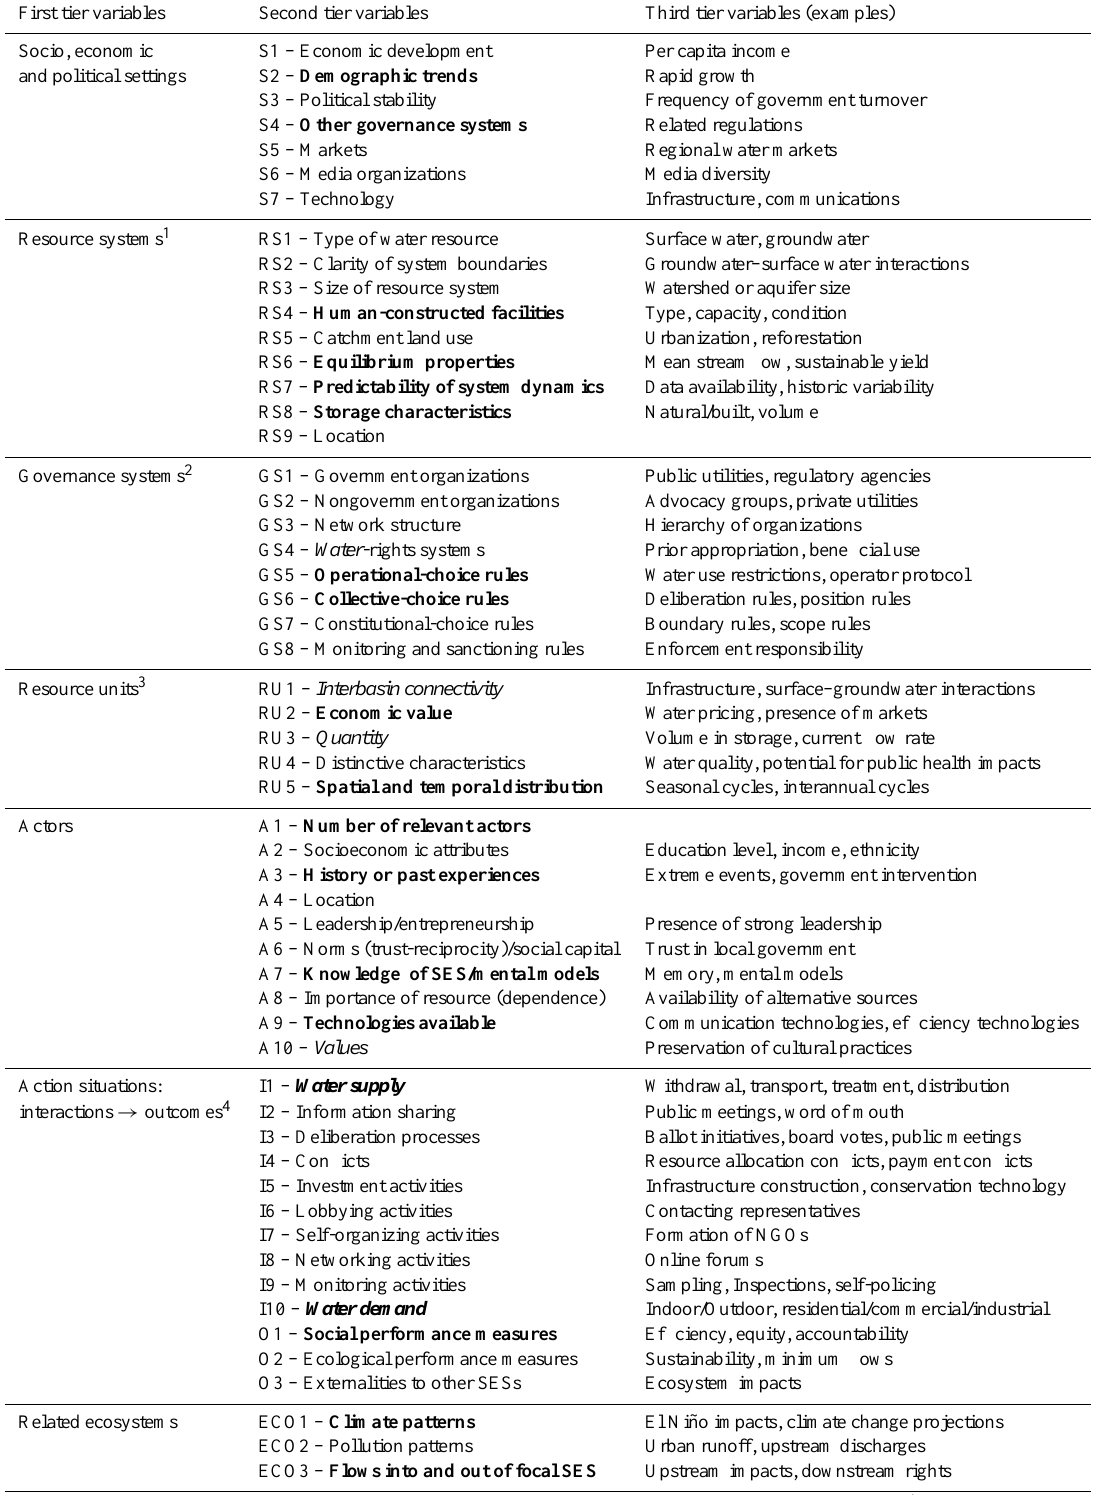
Table 3. SES framework, modified for urban water